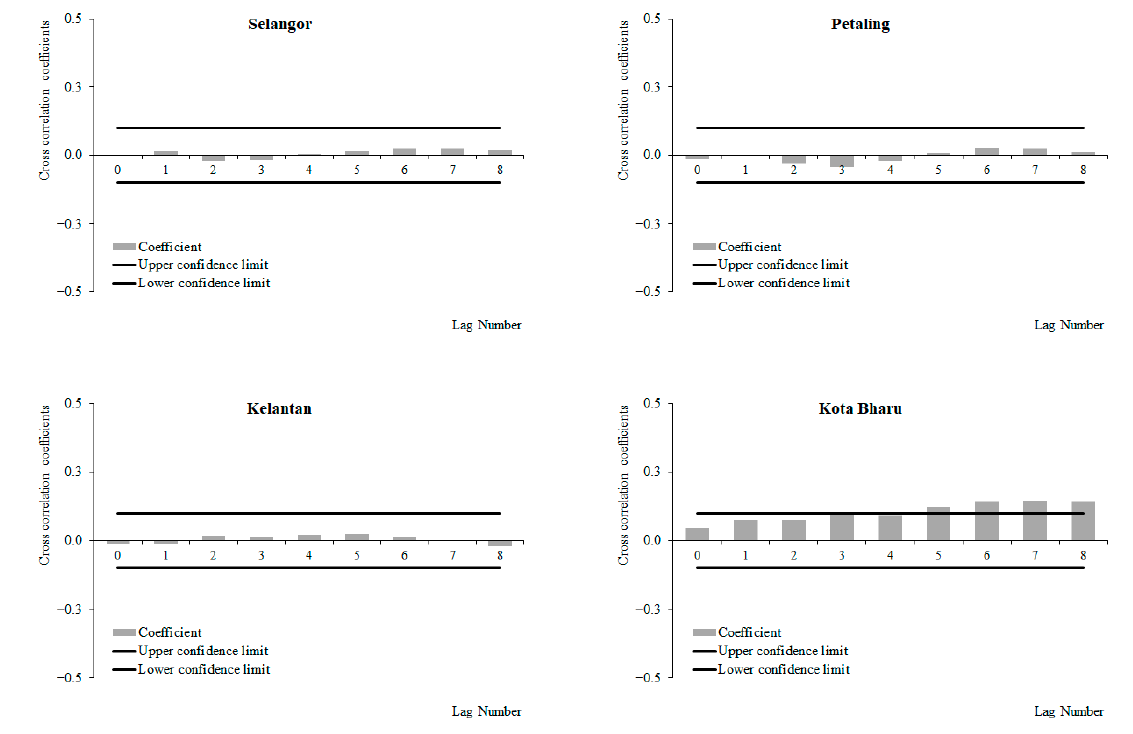
Figure 14. Cross-correlation function between dengue cases and wind speed in Selangor, Petaling, Kelantan and Kota Baharu, 2011 to 2014.